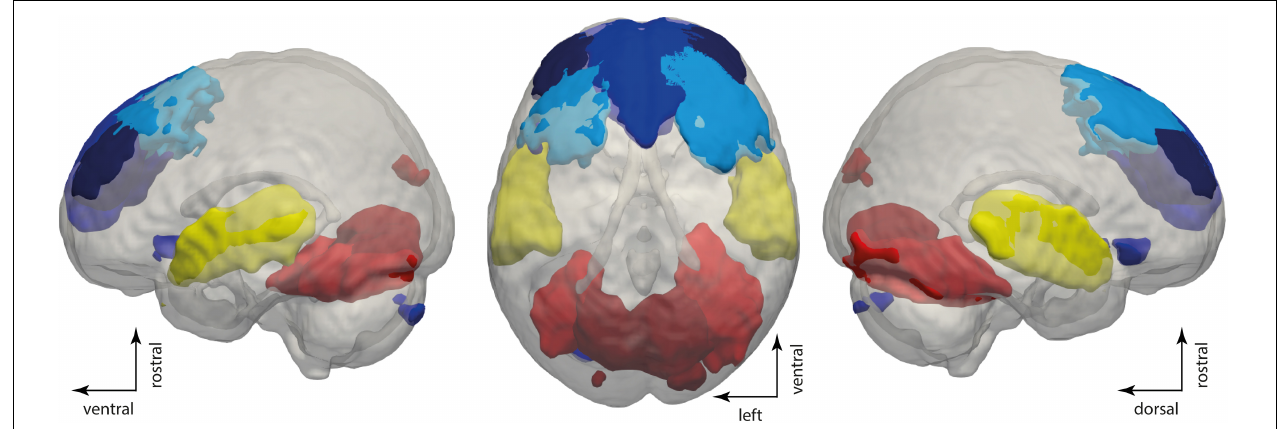
FIGURE 4 | Specific network activity is related to the appearance of conscious-related patterns. Rendering showing the dorsolateral and dorsomedial prefrontal cortices in blue, primary auditory cortices in yellow, and visual cortices in red. The rendering shows maps of the independent components with a threshold of p < 0.05 family-wise error correction in